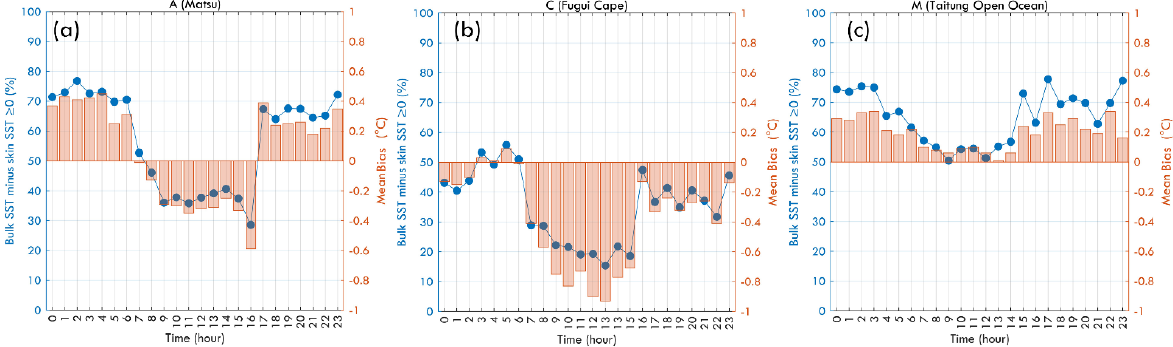
Figure 7. Three different types of bulk and skin SST diurnal variations. (a) The near-surface SST gradient had obvious diurnal variation, (b) ocean near-surface skin SST was more likely to be warmer than bulk SST, and (c) ocean near-surface skin SST was more likely to be cooler than bulk SST.